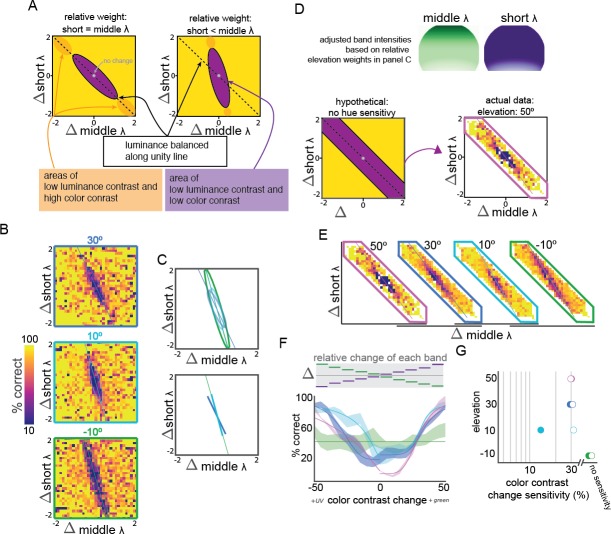
Relative short and middle-wavelength band weights and color discrimination across elevation.(A) Schematic representation of two possible relative short and middle band weight scenarios, including some putative color contrast sensitivity. The left scenario shows equal weight of short and middle bands, leading to balanced sensitivity and chance performance in response to equal and opposite changes in short and middle band contrast, along the unity line. The right scenario shows higher middle band sensitivity, resulting in a positive shift of the slope, where the larger changes in short band contrast are required to balance changes in middle band contrast. For both scenarios, low luminance and hue contrast should yield low change detection performance (purple ellipses). Any hue discrimination occurs along the major axis of this purple ellipse, and color contrast is high near the edges (orange ellipses). Axes indicate change in each wavelength band intensity, combining the same relative changes in color and luminance across many absolute hue, chromaticity, and luminance values. (B) Observed relative weights of short and middle band weights, as in panel A., at elevations of −10° (green outline, bottom), 10° (light blue outline, middle), and 30° (dark blue outline, top). (C) Fit of the relative weights in panel B with two-dimensional Gaussians, including a plot of the major axis of the fit. These major axes are isolated in the plot below. Color corresponds to stimulus elevation (green lines: −10°, light blue lines: 10°, dark blue lines: 30°). (D) Schematic of sensitivity testing after adjusting for the wavelength band weights in panels B and C (top panels showing adjusted intensities across elevation, normalized to the non-adjusted values. Following this adjustment, the central region should be along the line of equiluminance (bottom left), so subsequent testing was focused on this spear-like region (arrow to bottom right). Actual data at elevation = 50° same as panel E. (E) Performance of change detection at four elevations (green lines: −10°, light blue lines: 10°, dark blue lines: 30°, pink lines: 50°) after short and middle weights adjustment. Because short and middle weight were not exactly balanced, performance was fit with a two-dimensional Gaussian and color sensitivity measured along the major axis (lines overlaid on each plot). (F) Hue sensitivity at each elevation. Fit with hyperbolic ratio function is shown overlaid on mean performance; mean performance line thickness shows S.E.M. across mice. The stimulus is schematized above the performance, showing the corresponding equal and opposite relative change in each wavelength band for each condition. (G) Contrast sensitivity at each elevation, from fits in panel F. Closed circles: decrements in contrast, open circles: increments in contrast.